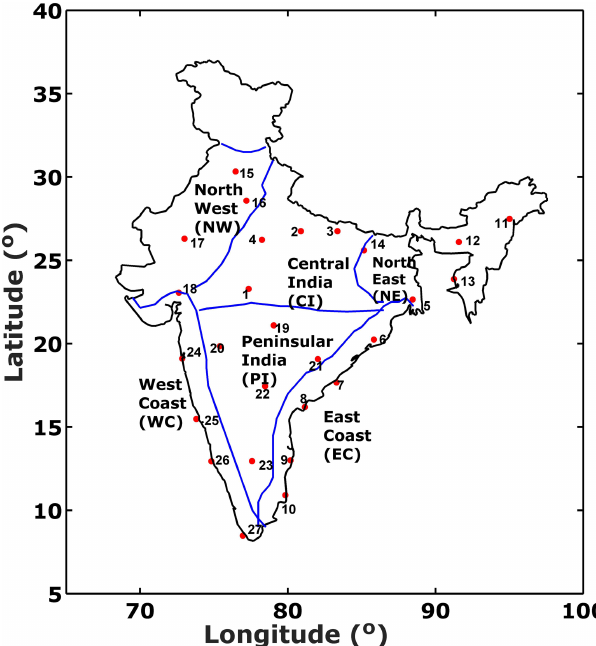
Figure 1. The locations of the 27 IGRA stations used for the present study. The distribution of the 27 stations over Indian regions is as follows: 4 stations in CI, 6 stations in EC, 4 stations in NE, 4 stations in NW, 5 stations in PI, and finally 4 stations in